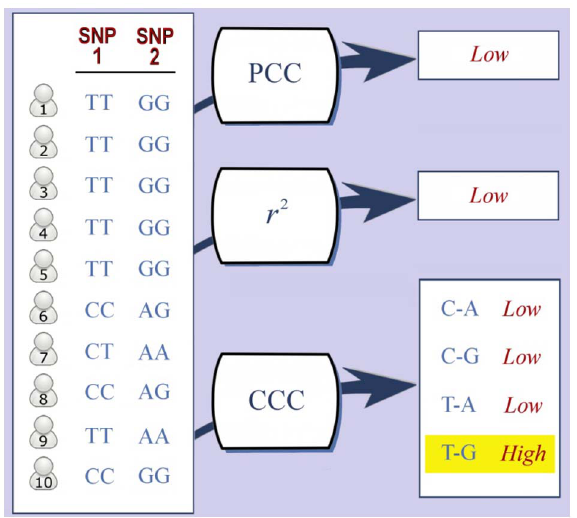
Figure 1. Genotypes for ten individuals for a pair of SNPs. The first five individuals are perfectly correlated, but the others are not correlated at all. The absolute value of PCC is 0.3 and r 2 returns 0.0, due to the uncorrelated individuals. CCC supplies four correlation values, each of which corresponds to a specific type of correlation. These values are low for three of the possible combinations, but a high value of 0.7 for the T-G combination was returned.